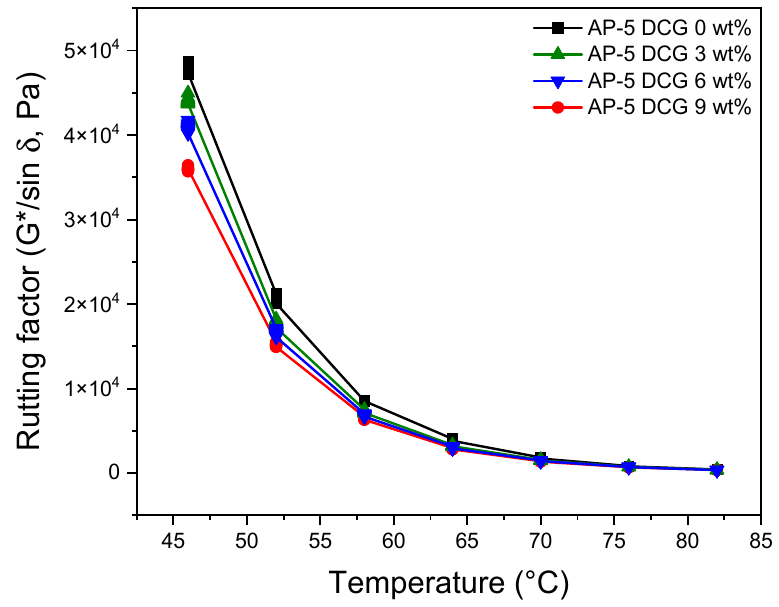
Figure 12. Variation of rutting factor (G*/sin δ ) as a function of temperature for unaged base AP-5 asphalt and its modified specimens comprising various doses of DCG (e.g., 3, 6, 9 wt%).